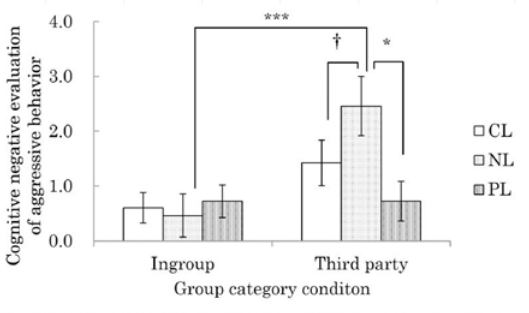
Fig 2. Effects of group category and labeling on the cognitive negative evaluation of aggressive behavior.